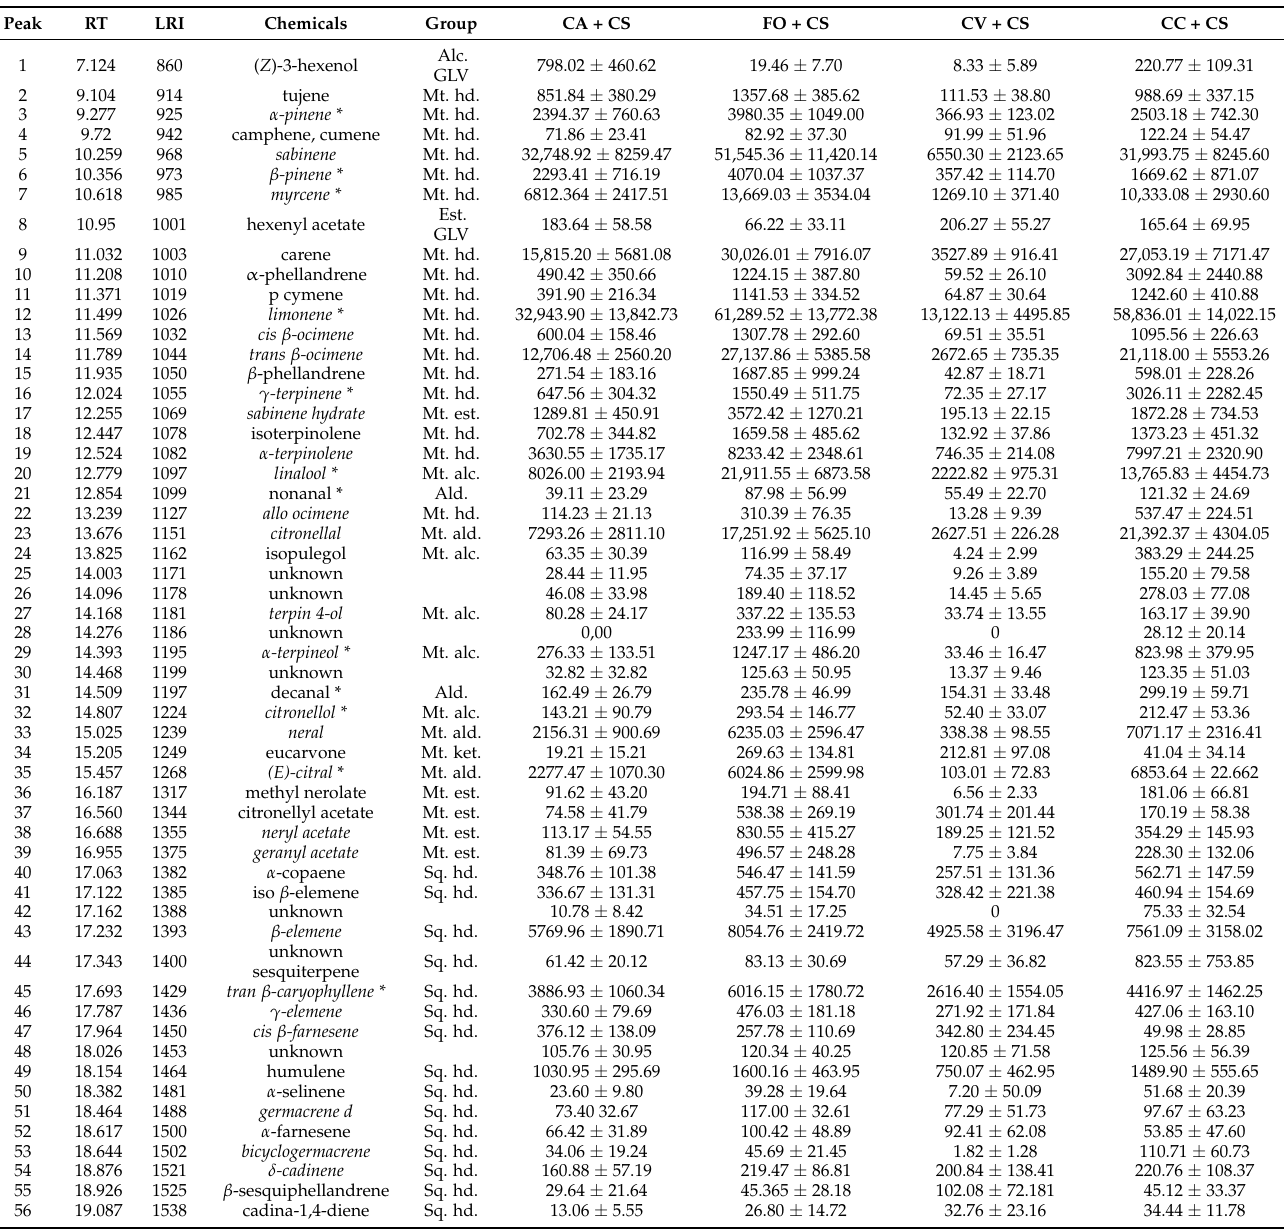
Table 2. Volatile emissions 1 of Citrus sinensis (CS) leaves grafted on the different rootstocks Citrus aurantium (CA), Volkamer lemon (CV), Carrizo citrange (CC), and Forner-Alcaide no. 5 (FO) collected using headspace SPME. The compounds found also in the rootstock without scion reported in Guarino et al. [16] are in